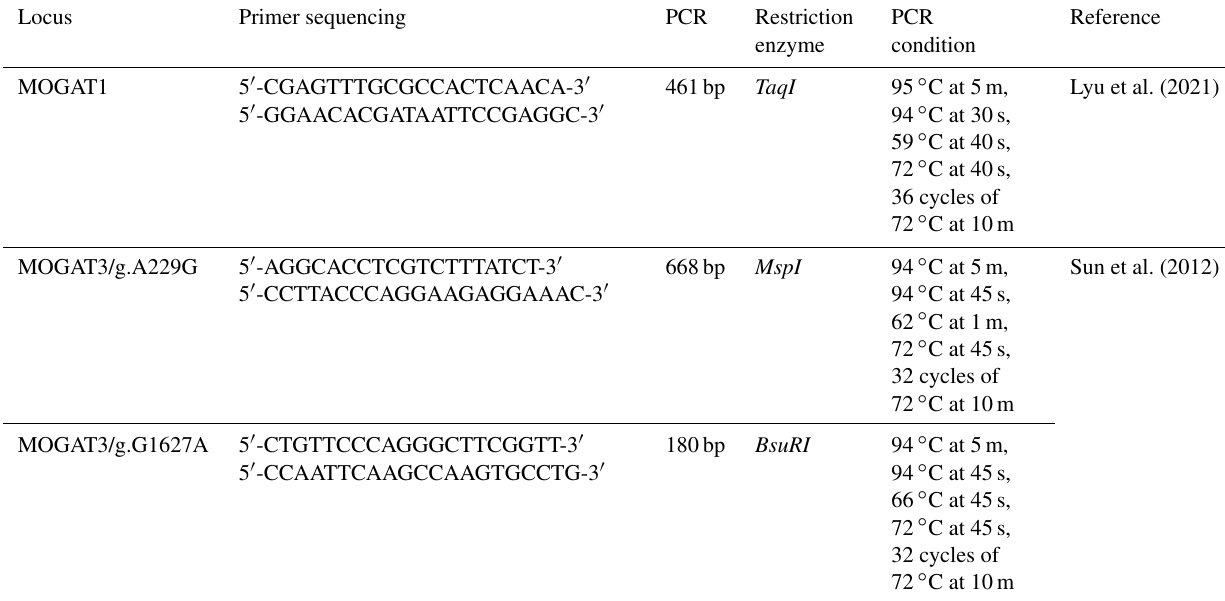
Table 1. The MOGAT1 and MOGAT3 primer sequence and PCR condition. Locus Primer sequencing PCR Restriction